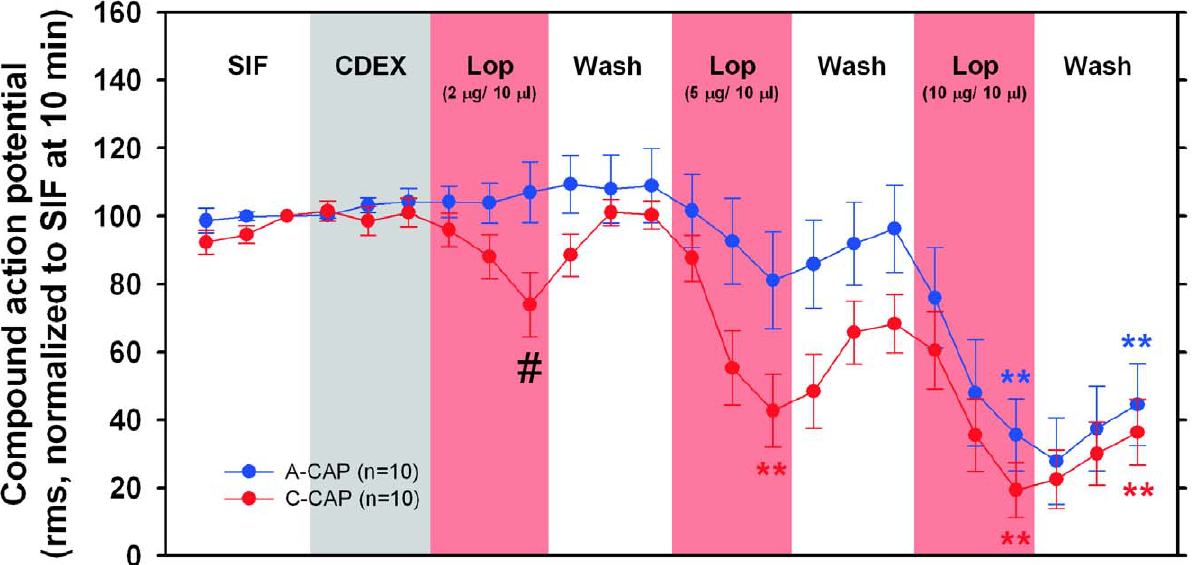
Figure 6. Loperamide produces a conduction blockade in A and C fibers in the peripheral nerve. The A-CAPs (blue circles) changed significantly with different incubation steps (Friedman ANOVA, p , 0.001). After incubation with the highest loperamide dose, the A-CAP was significantly reduced compared to A-CAP under CDEX (10th min) (**p , 0.01, Wilcoxon-matched pairs with correction for multiple testing). The C-CAP (red circles) also changed significantly during the course of the experiment (Friedman ANOVA, p , 0.001). Under loperamide (5 and 10 m g/10 m l), the C-CAP significantly decreased compared to CDEX C-CAP (**p , 0.01, Wilcoxon-matched pairs with correction for multiple testing). At the lowest loperamide concentration (2 m g/10 m l), the C-CAP was significantly smaller than the A-CAP ( # p , 0.05 Mann Whitney U